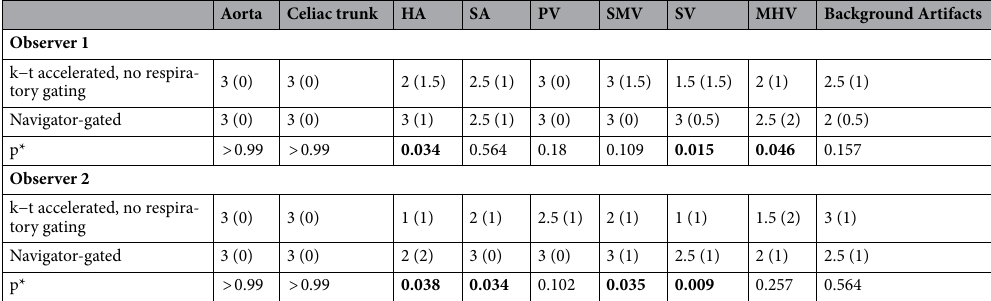
Table 1. Qualitative scoring of vessel conspicuity and background artifacts with the two acquisitions, as evaluated by two observers. Data is shown as median (IQR) of the vessel conspicuity (0: vessel not seen; 1: severely to moderately blurred; 2: mildly blurred; and 3: well delineated) and background artifacts scores (1: severe artifacts; 2: moderate; 3: minimal or none). Vessel conspicuity scores for the two acquisitions were equivalent in large vessels, but significantly lower for the k−t accelerated acquisition in the hepatic artery and splenic vein ( p < 0.05 is shown in bold font). Significant differences on paired Wilcoxon test ( p * < 0.05) are shown in bold font. HA hepatic artery, MHV middle hepatic vein, PV portal vein, SA splenic artery, SMV superior mesenteric vein, SV splenic